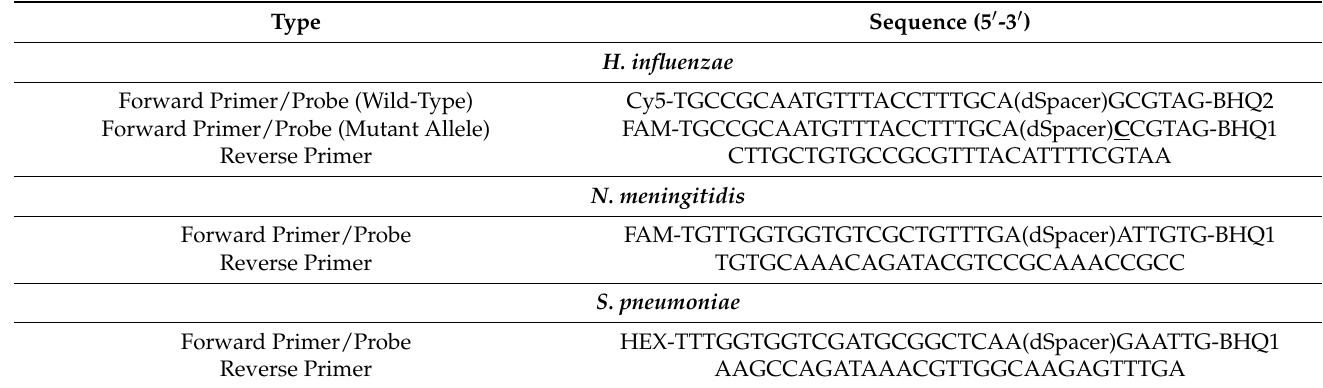
Table 1. 3TEC-PCR oligonucleotides.